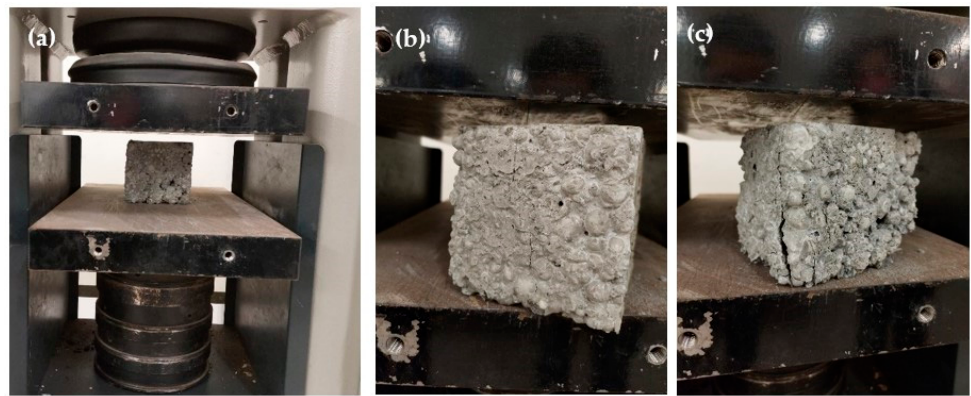
Figure 3. Experimental setup of the compressive test: ( a ) initiation of the test; ( b ) failure mode of D-LWC Mix2; ( c ) failure mode of D-LWC+PET Mix2.